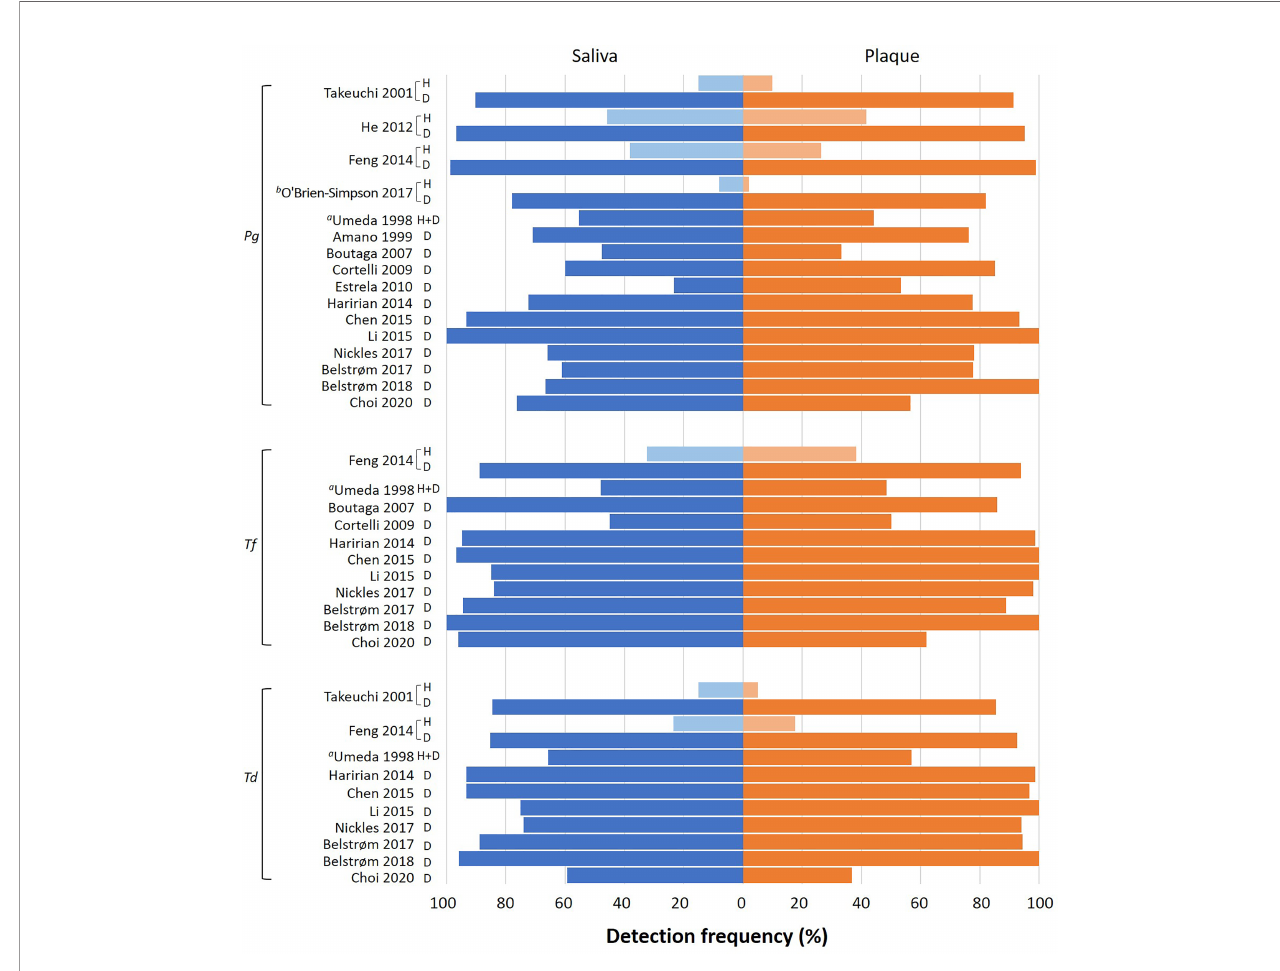
FIGURE 3 | Overview of the detection frequency of P. gingivalis ( Pg ), T. forsythia ( Tf ) and T. denticola ( Td ) in saliva and subgingival plaque samples reported in each study. H: healthy subjects; D: periodontitis patients. Pooled subgingival plaque samples were used for analysis unless speci fi ed otherwise. a This study mentioned 3 groups of subjects (health, gingivitis and periodontitis), but the data of different subject groups were reported together. b This study analyzed the subgingival plaque samples from 6 periodontal pockets